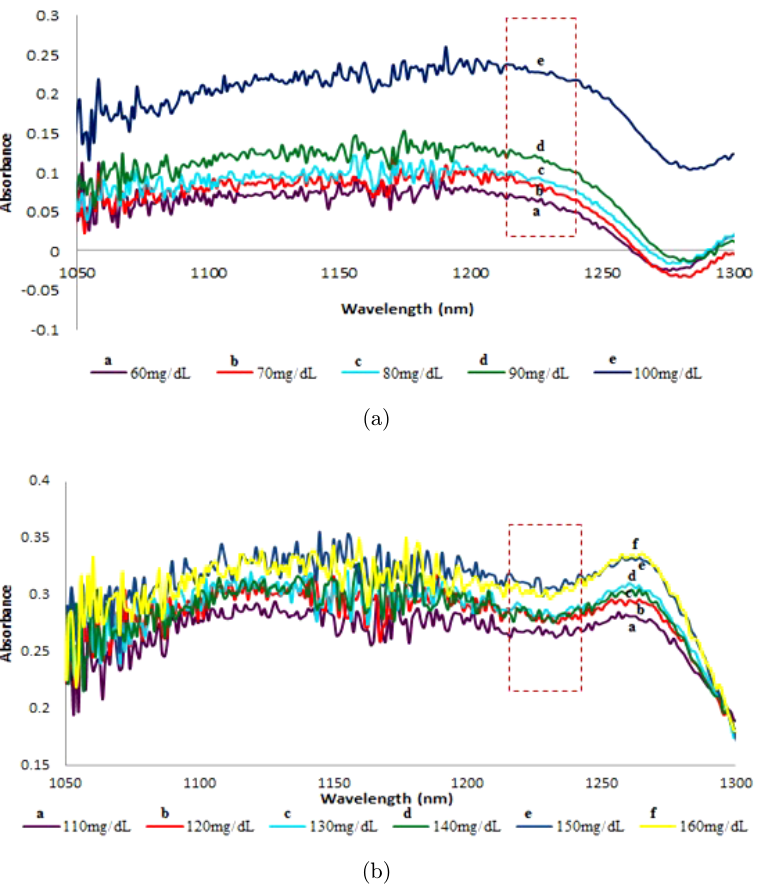
Fig. 4. Absorbance spectrum for LED1200E with (a) glucose concentration range of 60 to 100 mg/dL (b) glucose concentration range of 110 to 160